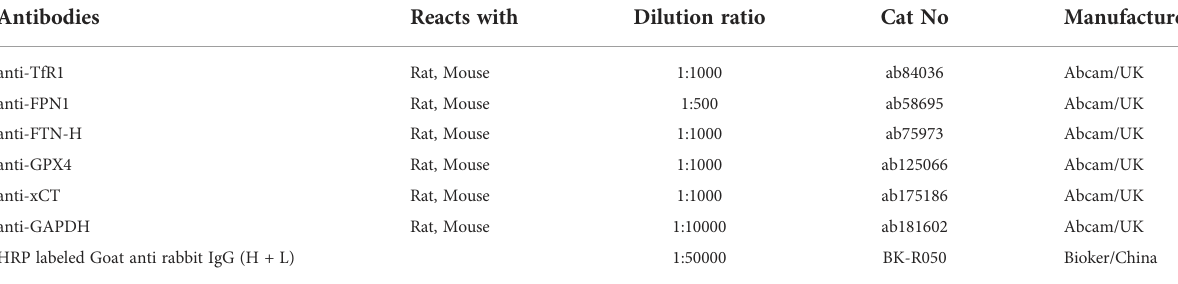
TABLE 2 The antibodies and dilution ratio.